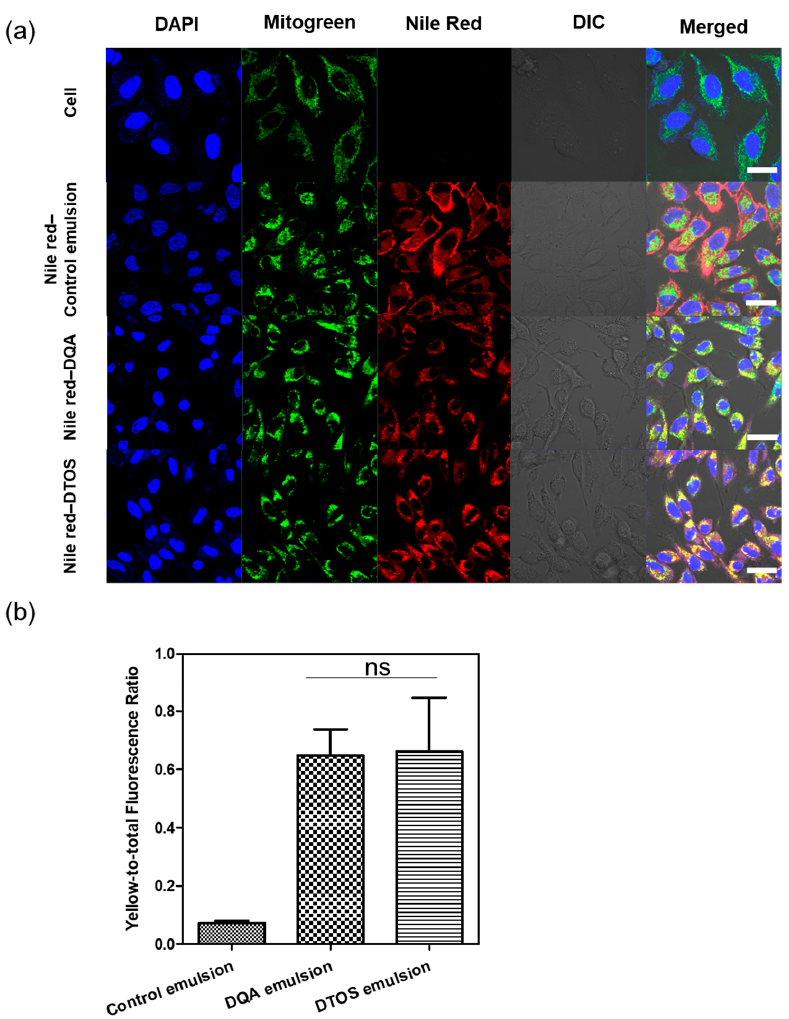
Figure 6. ( a ) Confocal laser scanning microscopy images of HeLa cells after 24 h of incubation with the Nile red emulsion. Labeled nanoparticles are shown in red (Nile red). The mitochondria are stained with MitoGreen. The cell nucleus is stained blue by 4 ′ ,6-diamidino-2-phenylindole (DAPI). DIC, differential interference contrast; DQA, dequalinium emulsion; DTOS, DQA/ α -TOS emulsion. The scale bar represents 30 μ m. ( b ) The DTOS emulsion showed significant colocalization with mi- tochondria comparable to the DQA emulsion. Data points are represented as mean ± SD (n = 3 im- ages for each group). Statistical analysis was conducted using t-test. ns: not significant. The scale bar represents 30 μ m.